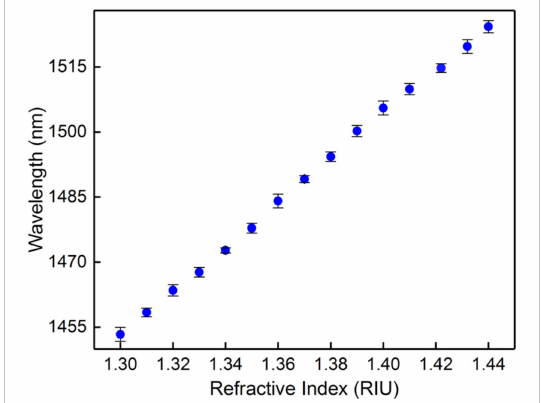
Figure 9. E ff ective RI sensitivity of the cuto ff mode.